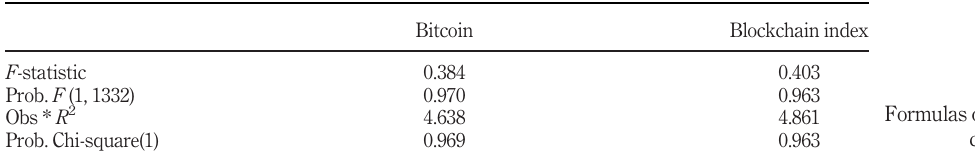
Table X. Formulas of